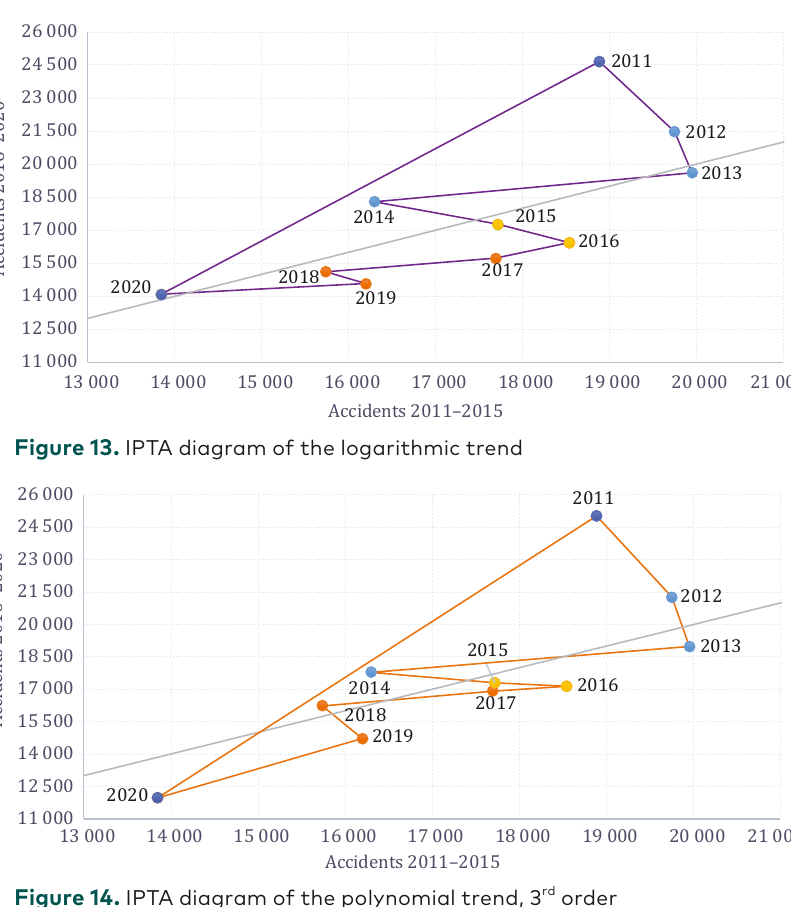
Figure 14. IPTA diagram of the polynomial trend, 3 rd